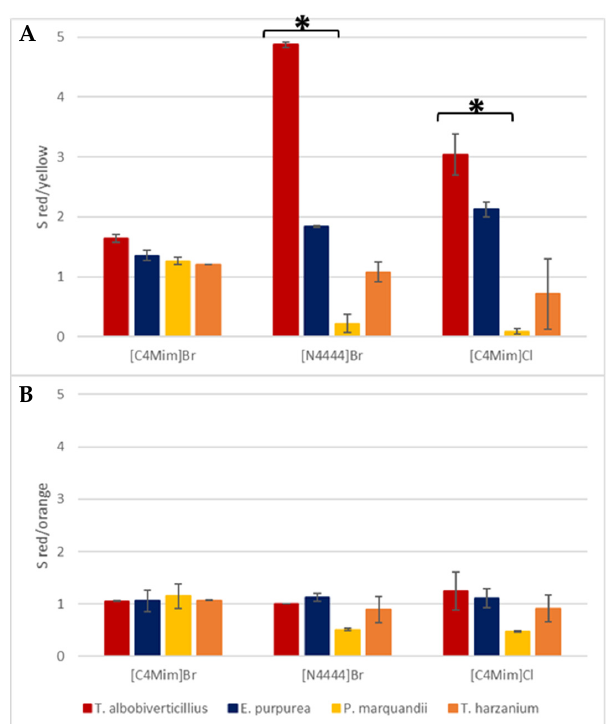
Figure 6. Extraction selectivity of red pigments over yellow pigments, S red/yellow ( A ) and over orange S red/orange ( B ) pigments for each strain in the four IL-ATPSs tested (* indicates p -values < 0.05, n = 3). Overall, in red-producing strains, the selective extraction of red over yellow co-produced colorants was strongly favored, as suggested by the high S red/yellow values ( i.e. ratio S red/yellow >>1) reported across the IL-ATPSs considered. In particular, we reported a statistically significantly better selectivity of red pigments’ extraction from T. albobiverticillius when using [N4444]Br - compared to [C4Mim]Cl - , while no significant difference was observed from E. purpurea . This suggested that the migration and selectivity of mixtures of pigments are greatly impacted by the features of the ILs used. As far as we can see and without knowing the detailed composition of pigments in the different mixtures, we confirmed that the [N4444]Br - -based ATPS was the most suitable extraction system for the selective isolation of red colorants across different hue-producing strains. On the other hand, little